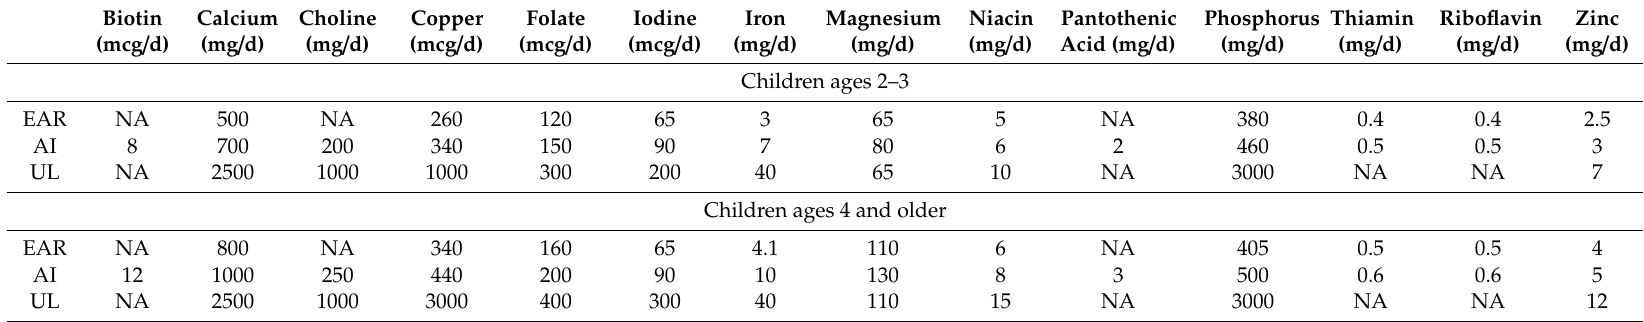
Table 2. Mineral-specific dosage recommended by the Institute of Medicine and Health Canada for Estimated Average Requirements (EAR), Recommended Dietary Allowances and Adequate Intakes (AI), and Tolerable Upper Intakes Levels